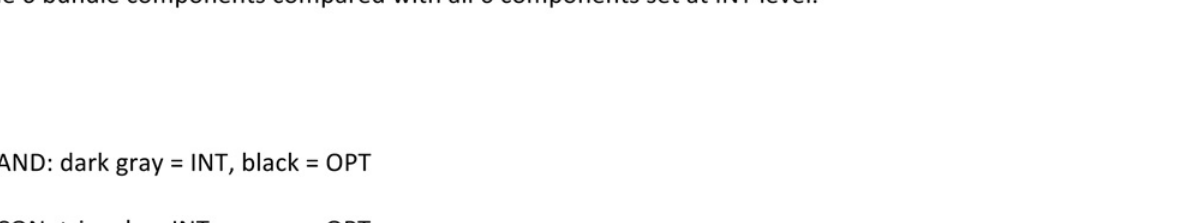
Fig 2. Scatterplot of incremental cost and effectiveness ( C . difficile infections averted) of intervention strategies compared with INT levels of all 6 bundle components. HAND: dark gray = INT, black = OPT; DCON: triangle = INT, square =